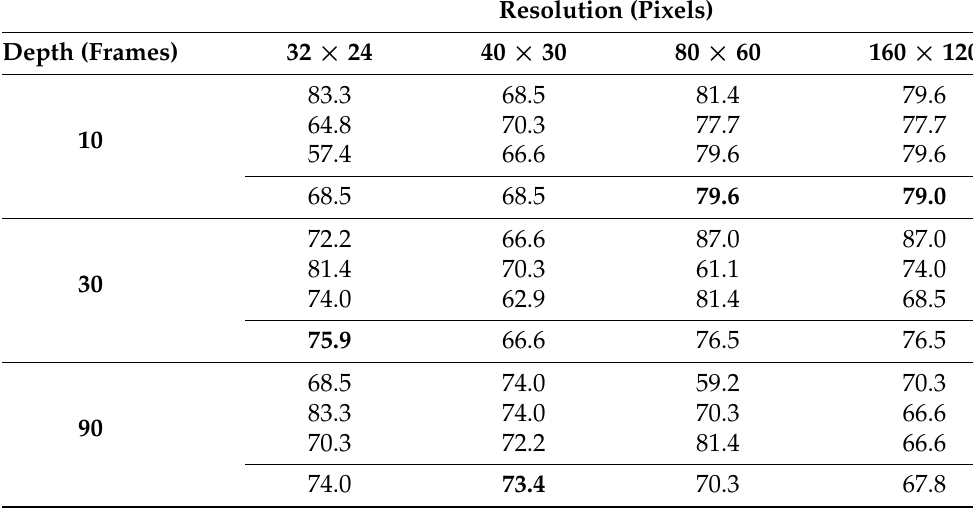
Table 8. Accuracy (%) of the models trained with the 12 different configurations from experiment C01 (unbalanced dataset with data augmentation). Each cell presents the accuracy of the three independent models per configuration and its average. The best results per resolution are highlighted in